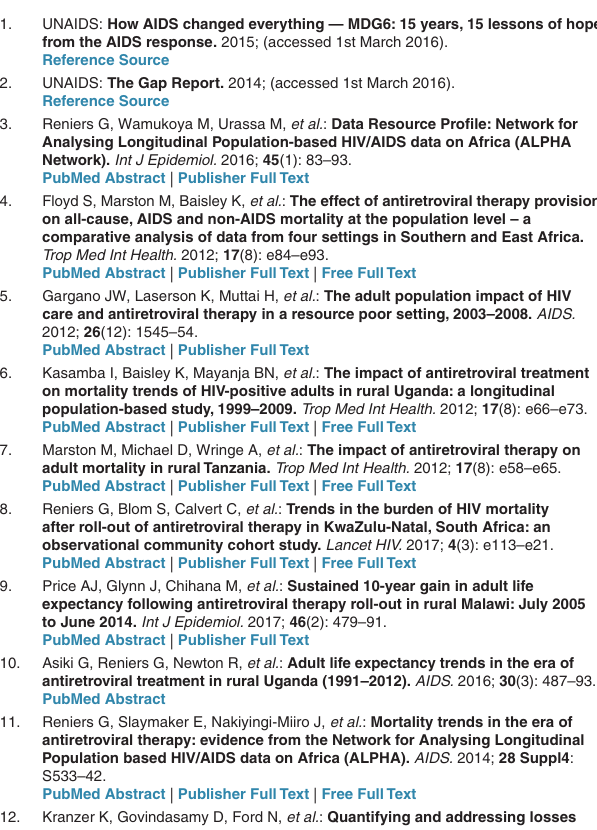
Supplementary material Supplementary File 1: Description of